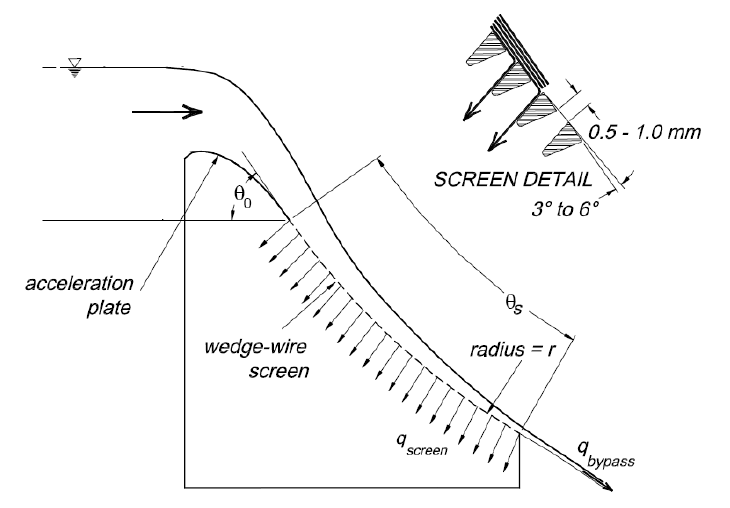
Figure 1. Side view of a typical Coanda-effect screen.